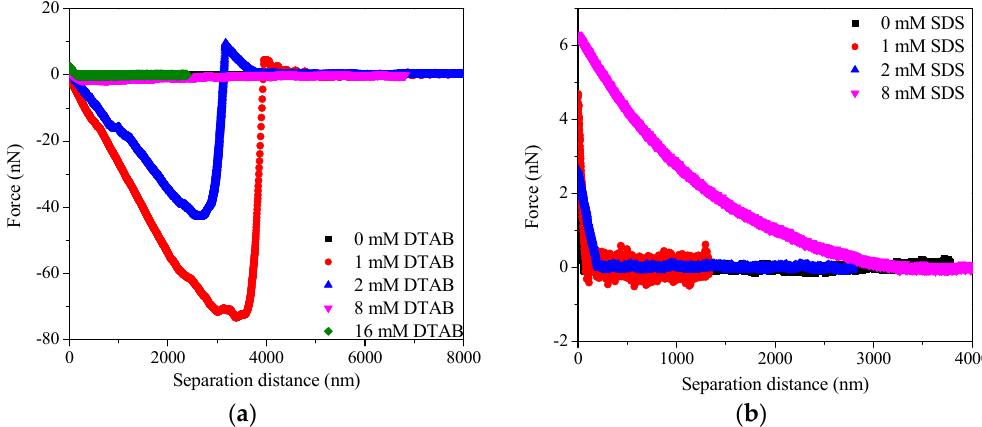
Figure 6. Effect of DTAB ( a ) and SDS ( b ) on the interaction force between hydrophilic glass microsphere and bubble.